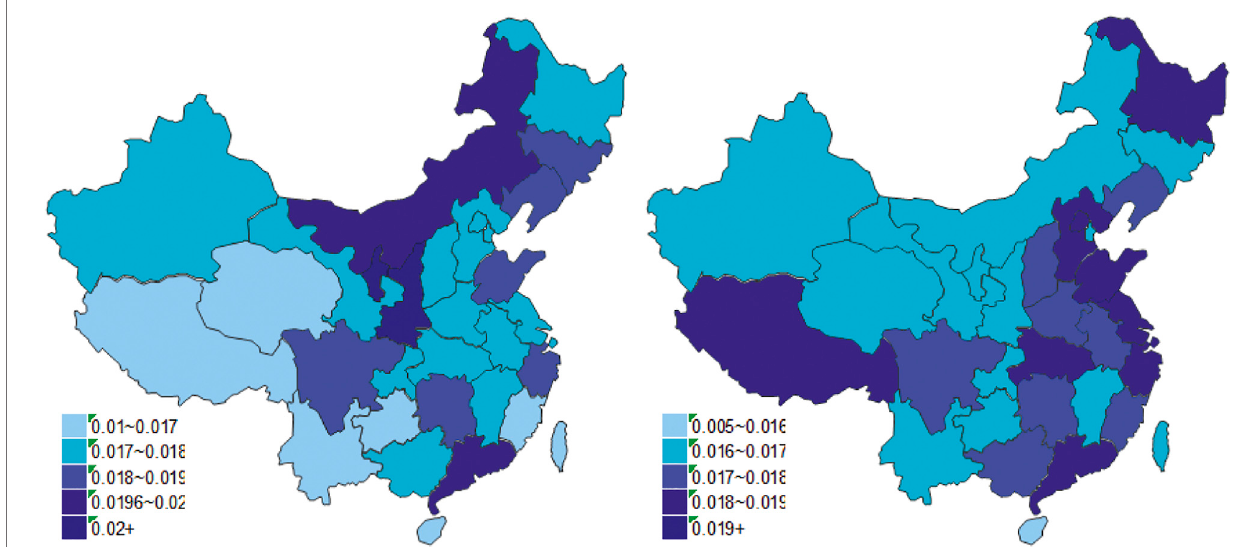
FIGURE 9 | The comparison of network density between 2011 and 2019.